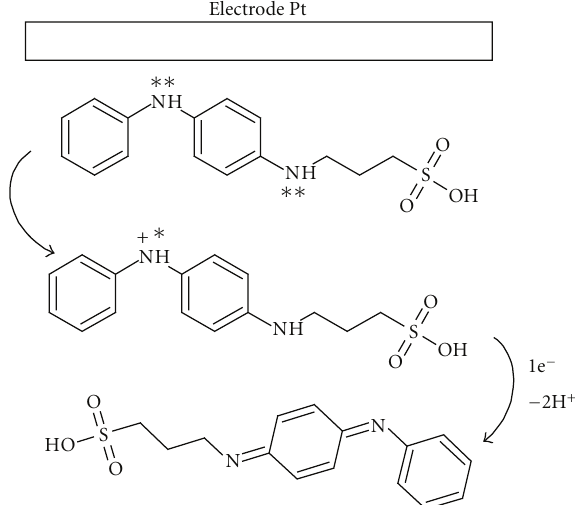
Scheme 1: Possible anodic oxidation process of the DAnPS mon- omer, at the Pt electrode